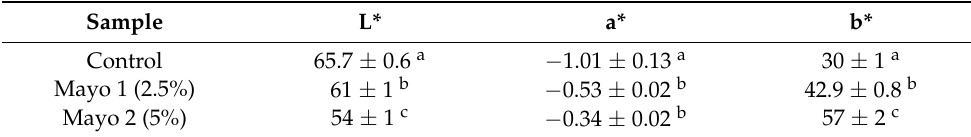
Table 7. Color characteristics of value-added mayonnaise.